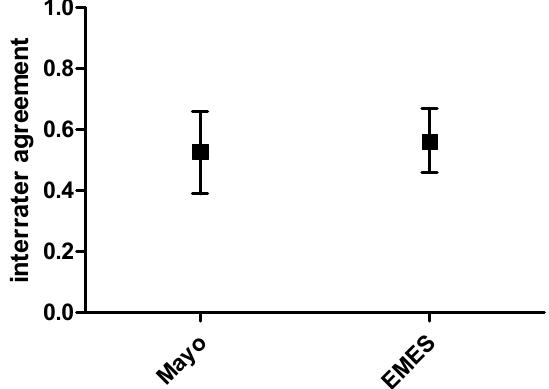
Figure 4. Inter-rater agreement on EMES and Mayo scores. Kappa values and 95% CI are